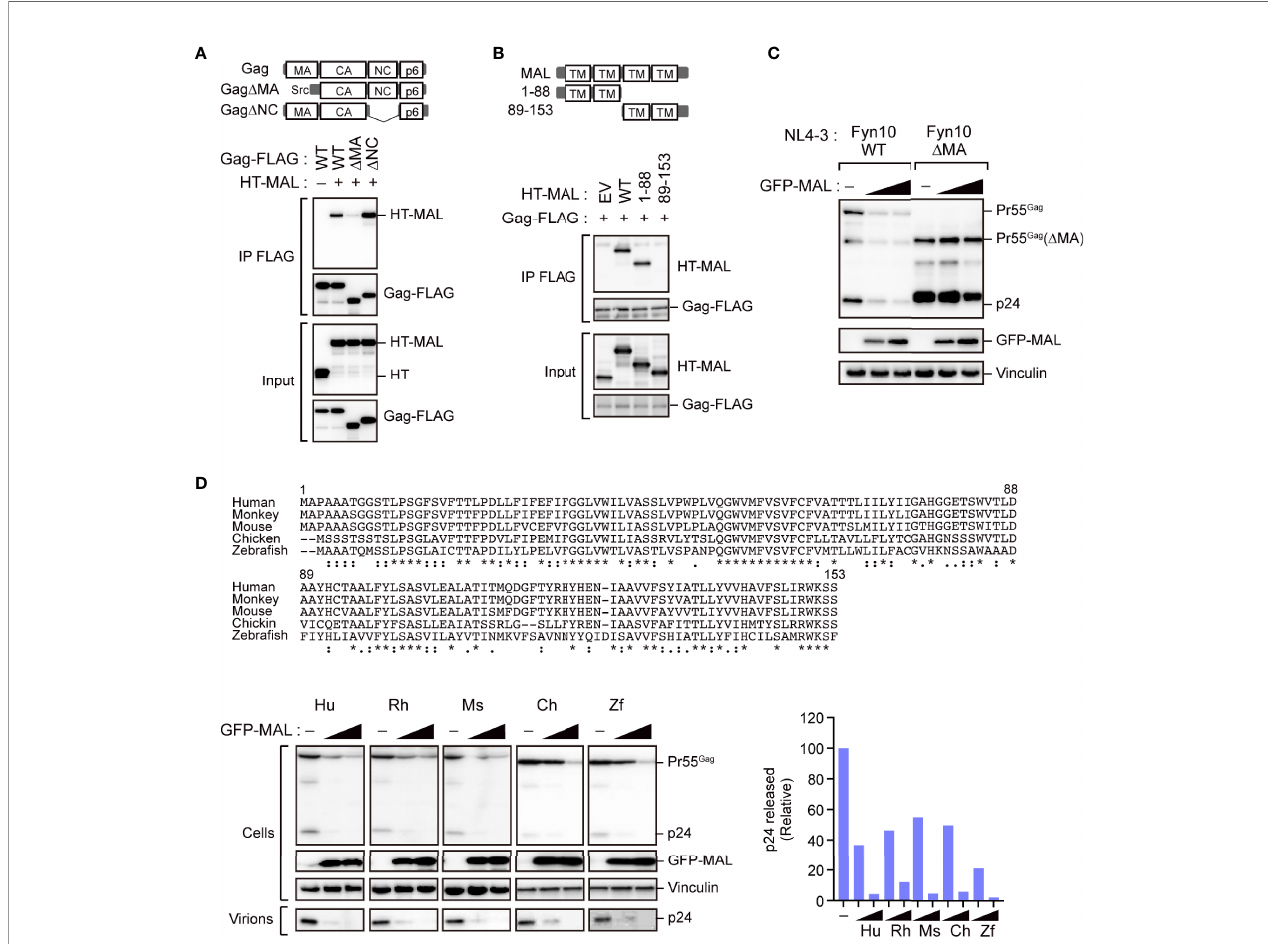
FIGURE 5 | The matrix domain of Gag is a major target for MAL-mediated inhibition. (A) MAL binds to the MA domain of Gag. Immunoprecipitation assays of HEK293 cells expressing the speci fi ed Gag-FLAG mutants and HaloTag (HT)-MAL. Cell lysates were precipitated with anti-FLAG antibodies, followed by immunoblotting. WT, wild-type; D , gene deletion. (B) N-terminus of MAL binds to Gag. Immunoprecipitation assays of HEK293 cells expressing the indicated HT-MAL mutants and Gag-FLAG. Cell lysates were precipitated with anti-FLAG antibodies, followed by immunoblotting. (C) MA-deleted Gag is resistant to MAL. HEK293 cells were co-transfected with pNL4-3/Fyn(10)full MA or pNL4-3/Fyn(10) D MA and GFP-MAL. Two days post-transfection, cell lysates were subjected to immunoblotting. (D) Antiviral activity of MAL is conserved across animal species. Sequence alignment of MAL across the speci fi ed animal species (top). The symbols below the alignment show the conserved residues (*), conservative substitutions (:) and semi-conservative substitutions (.). HEK293 cells were co-transfected with the HIV molecular clone pNL4-3 and the speci fi ed MAL expression vectors. Two days post- transfection, cell lysates (Cells) and the culture supernatants (Virions) were subjected to immunoblotting (bottom left). p24 antigen levels in the culture supernatants were also measured by ELISA (bottom